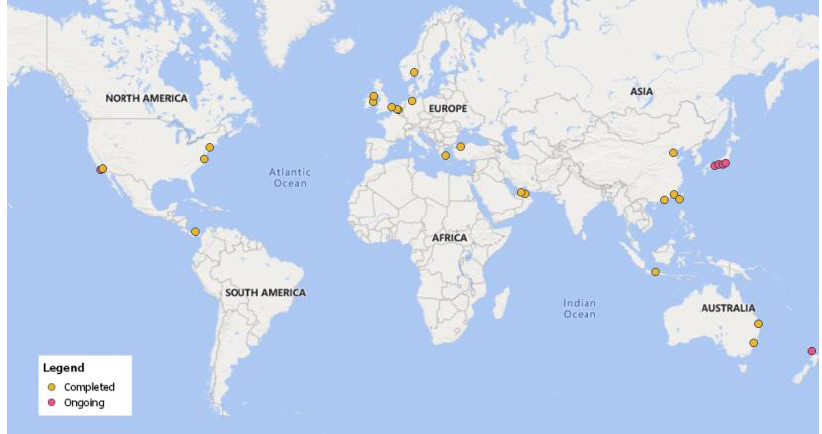
Figure 1. Completed and ongoing container terminal conversions (own elaboration over Google Maps TM ). Table 1. Sample of terminals studied and respondents.